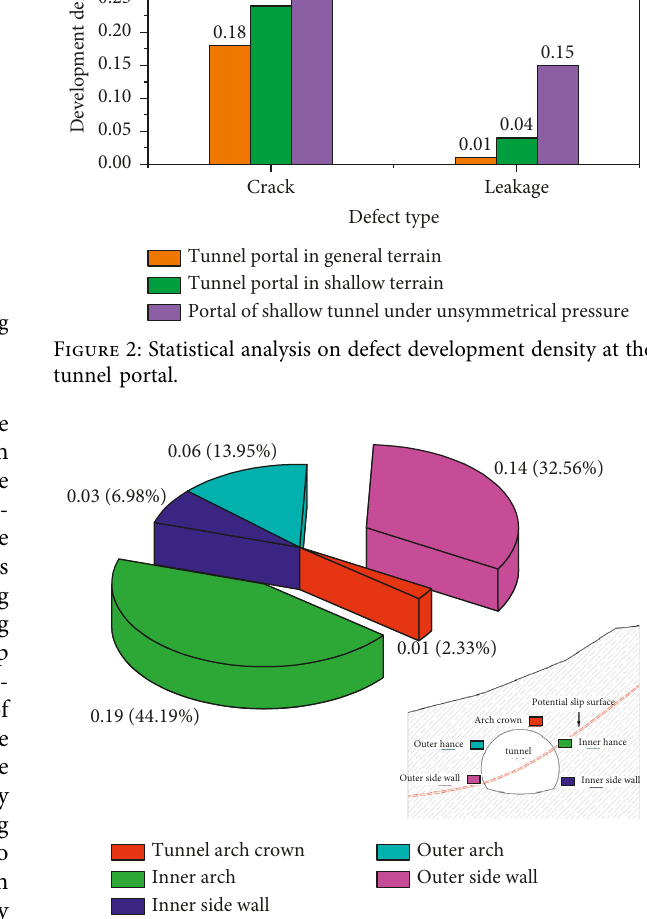
Figure 3: Statistical analysis on defect development density at the portal of shallow tunnel under unsymmetrical